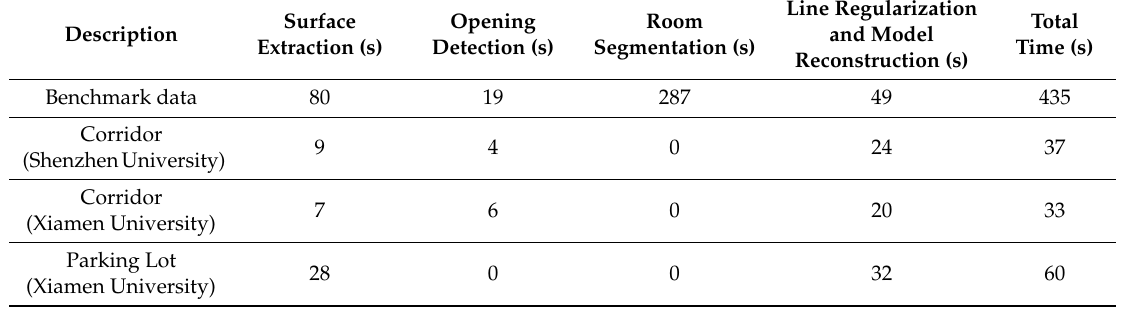
Table 5. Running time for di ff erent scenes.